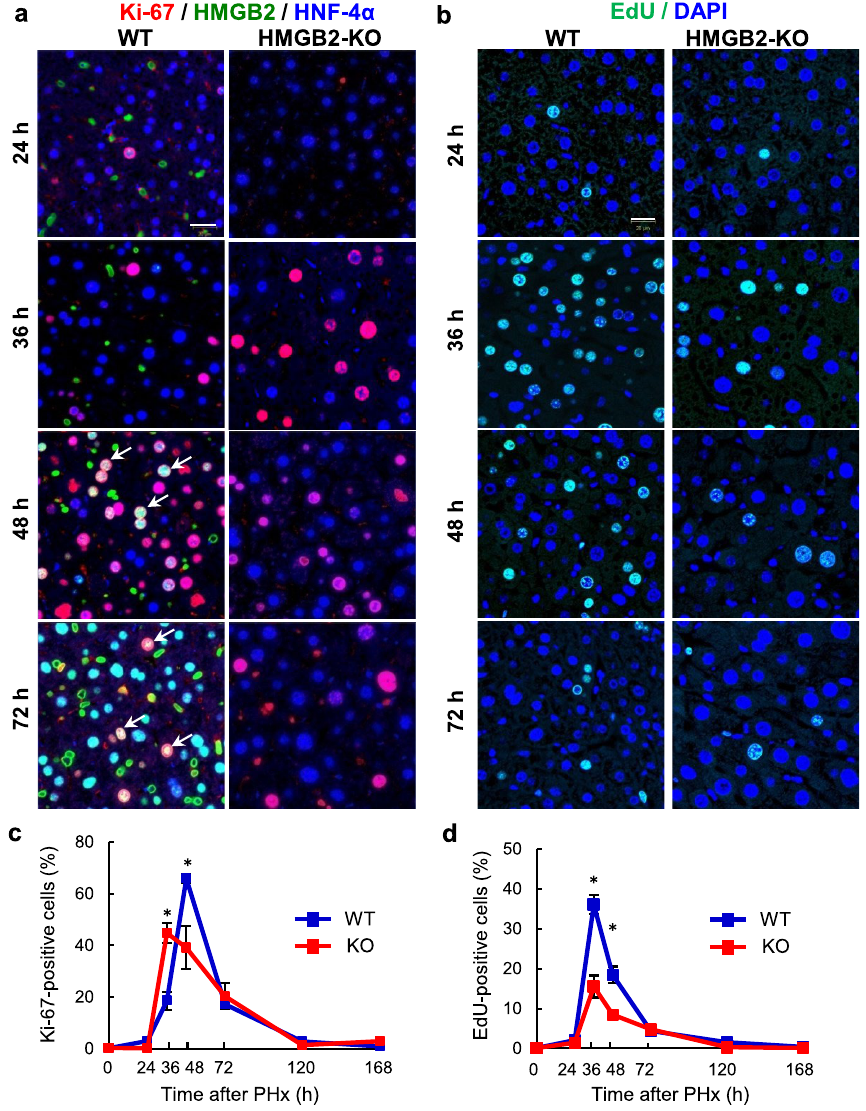
Figure 3. Expression of Ki-67 and EdU during liver regeneration. ( a ) Immunofluorescence for Ki-67 (red), HMGB2 (green) and HNF-4α (blue) in WT and HMGB2-KO mouse livers after PHx. Arrows indicate HMGB2- and Ki-67-positive hepatocytes. ( b ) EdU (green) and DAPI (blue) staining in WT and HMGB2-KO mouse livers after PHx. Scale bar 20 μm. Counting results of Ki-67-positive cells ( c ) and EdU-positive cells ( d ) in WT and HMGB2-KO mouse livers. Data represent the mean ± SEM from 5–6 mice per group. Asterisks indicate statistically significant differences (* p <